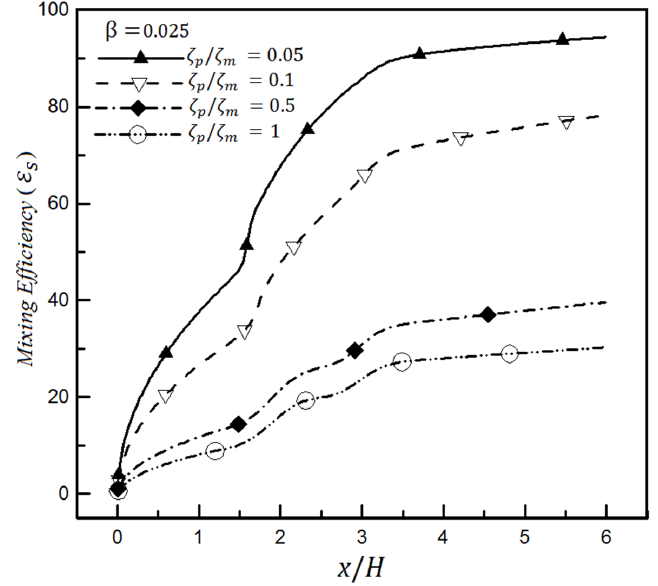
Figure 17. Mixing efficiency changes based on mixing entropy index in a heterogeneous microchannel for different zeta-potential ratios and a slip coefficient of 0.025.